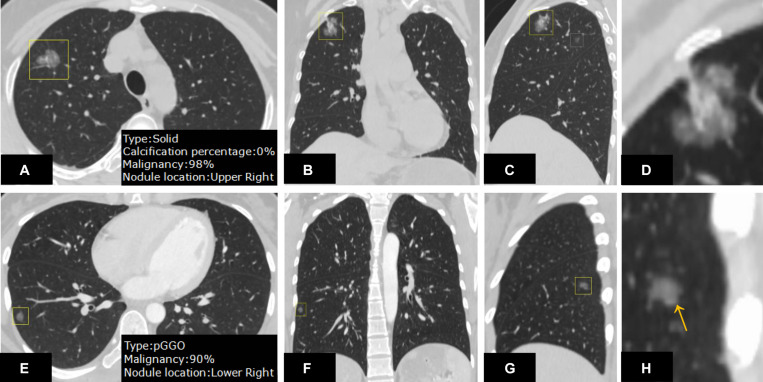
On the CT images from different views (A–C) and zoom-in view (D), a nodule in the right upper lobe was detected. DL-CADx subtyped this nodule as a solid nodule, while double reading characterized it as a part-solid nodule. By integrating these two disagreed results, a final consensus that this is a part-solid nodule has been reached through discussion. Differently, for the nodule detected on the CT images from different views (E–G) and zoom-in view (H), the first impression by double reading was a part-solid nodule in the left upper lobe because of seemingly a small patch of solid component (arrow). However, DL-CADx classified it as ground-glass nodule. After double checking and discussion, we misinterpreted a small vessel (arrow) inside the nodule as solid component and reached an agreement that this is a ground-glass nodule.